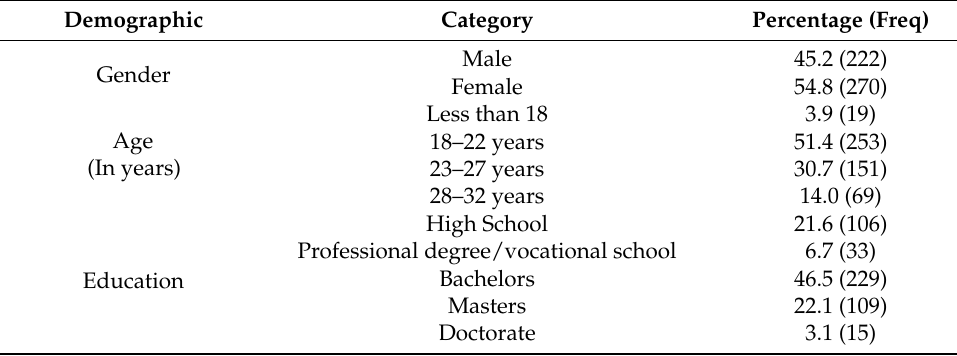
Table 1. Sample Characteristics ( N =